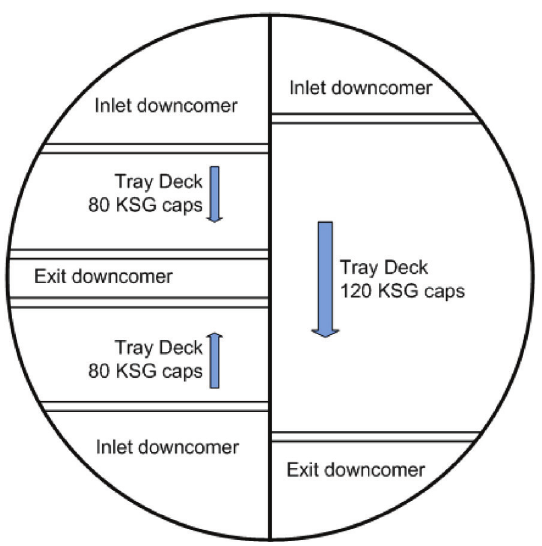
Fig. 5 – Layout of partitioned section of trayed DWC, with two-pass KSG trays on prefractionator side and single-pass trays on main column side (Full arrows indicate direction of liquid